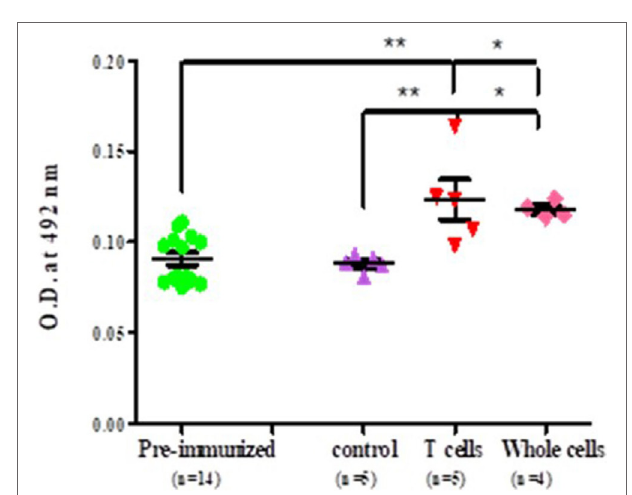
FigUre 5 | Level of antibodies against myosin proteins in adoptively transferred naïve female BALB/c mice. Each dot represents the individual OD. Horizontal line with error bars represent mean OD value with SEM. Control group adoptively transferred with whole cells and experimental group adoptively transferred with T cells and whole